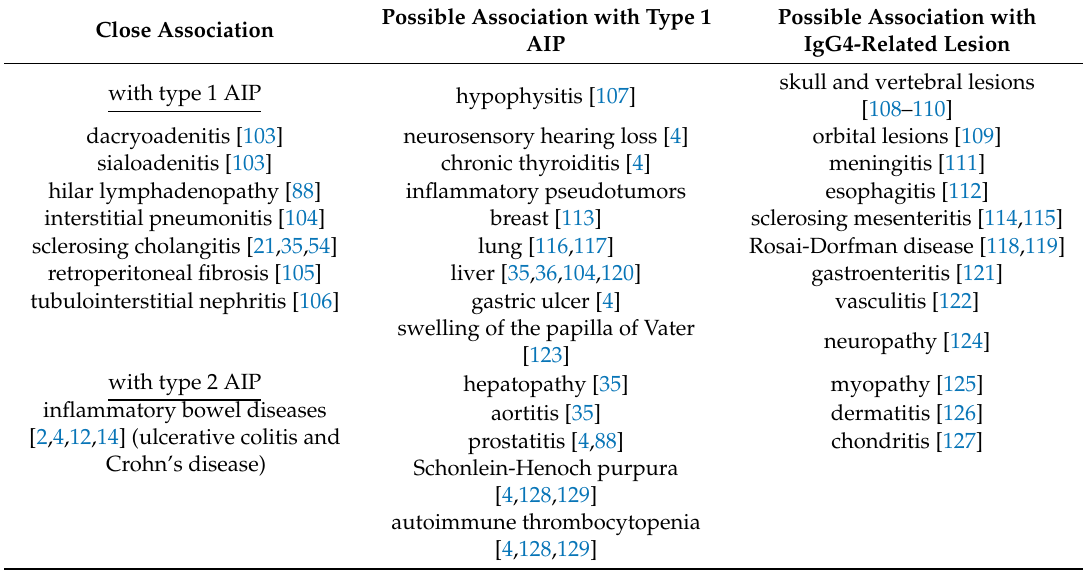
Table 2. Extrapancreatic lesions associated and possibly associated with AIP or IgG4-related